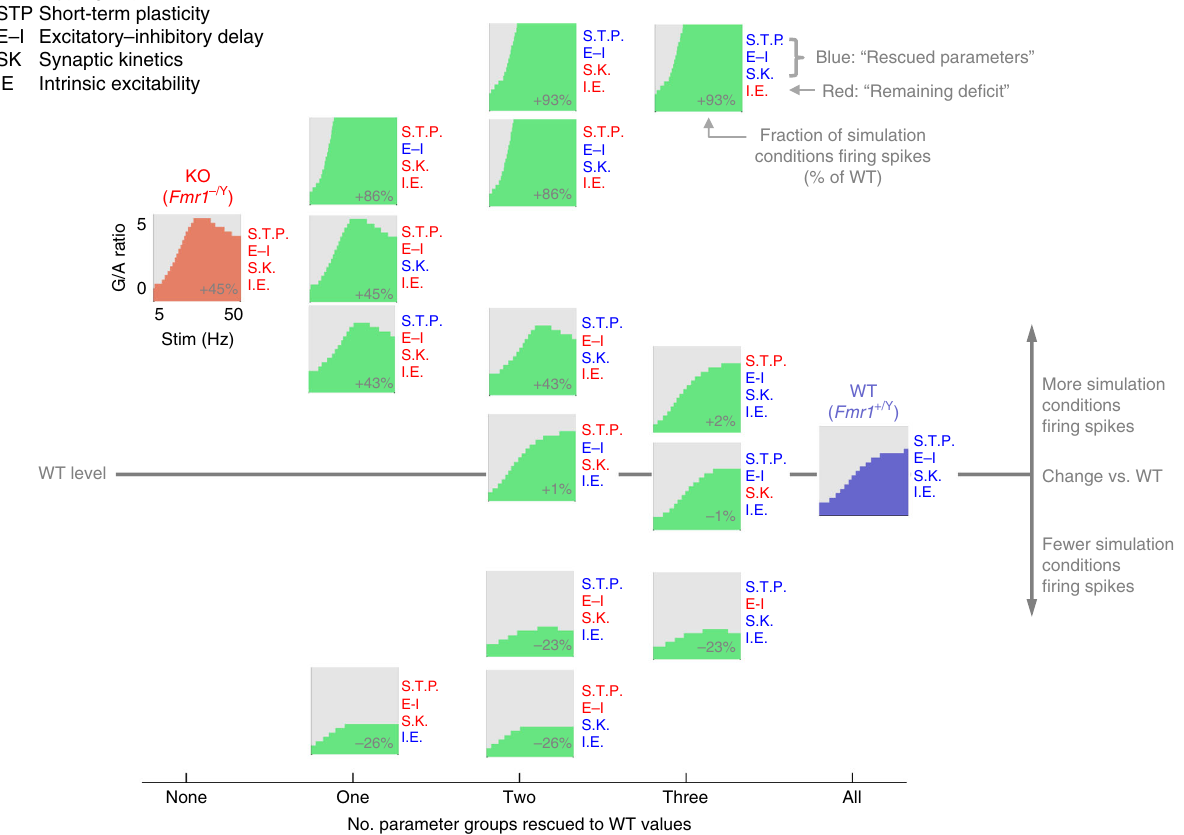
Fig. 8 Relative contributions of different mechanisms to dysfunction in the Fmr1-KO model. Model parameter space explored for 16 different possible combinations of simulated Fmr1 + /Y ( ‘ WT ’ ) and Fmr1 − /Y (KO) conditions (four parameter groups, two possible genotypes, i.e. 4 2 combinations). Spike fi ring conditions (in response to fi ve repetitive stimuli) are shown in green for each intermediate rescue scenario as well as Fmr1 − /Y to Fmr1 + /Y models. For each partial rescue scenario (either with Fmr1 + /Y or Fmr1 − /Y values, shown in blue and red, respectively), the total count of spike fi ring conditions across the whole 5 – 50 Hz and 0 < G/A < 10 range is shown compared with that of the wild-type simulation (i.e. full Fmr1 − /Y model fi red > 1 spike(s) in 45% more simulated FFI strength/input frequency conditions compared with the Fmr1 + /Y